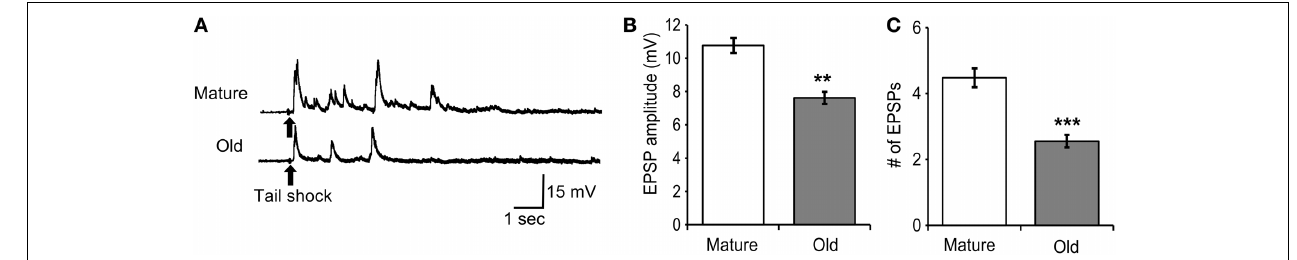
FIGURE 7 | Responses of tail motoneurons in situ following 70ms, 1mA tail shock declined with age. (A) Representative responses in mature and old tail motoneurons following tail shock. Motoneurons were hyperpolarized to − 90mV. (B) The amplitude of the first evoked EPSP decreased